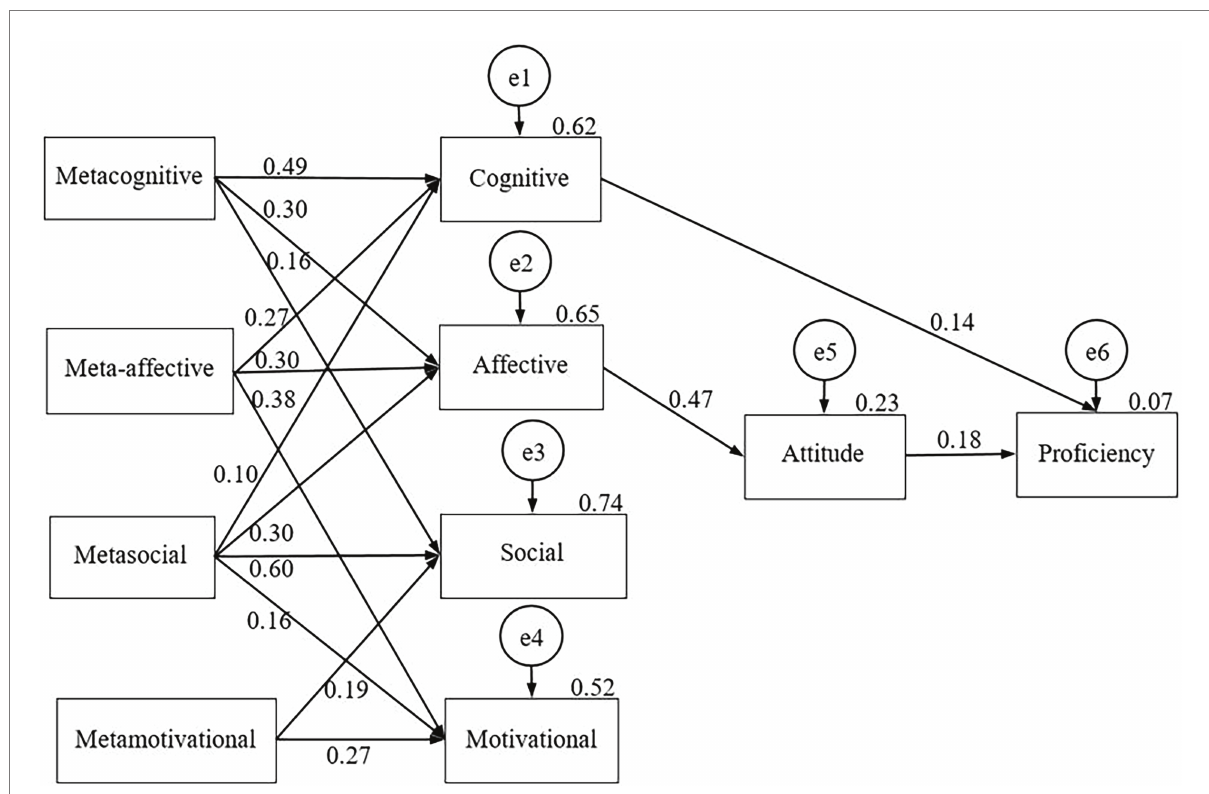
FIGURE 2 The path model for EFL metastrategies on regulation strategy use, attitude and English proficiency among elementary